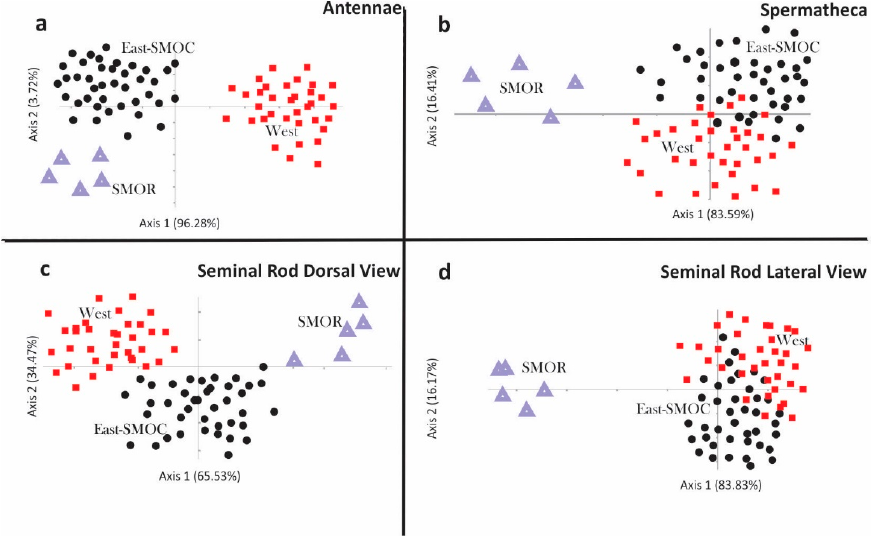
Figure 6. Scatter plots of individuals of different D . brevicomis populations in the first two canonical axis: ( a ) Females–males antennae, ( b ) spermatheca, and ( c , d ) seminal rod in dorsal and lateral view, respectively.